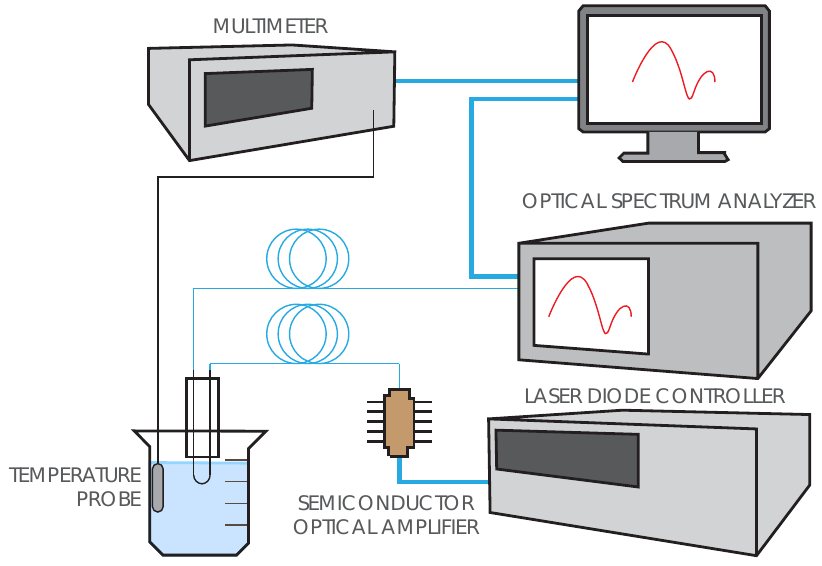
Figure 2. Sensor interrogation system. Amplified spontaneous emission from the semiconductor optical amplifier is used as the broadband light source in the 1450–1600 nm wavelength range. Data acquired from the optical spectrum analyzer was saved in a PC using